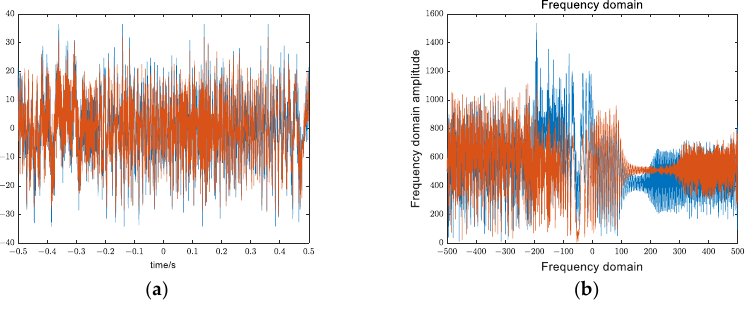
Figure 6. Mixed signal after mixed matrix. ( a ) Time domain; ( b ) Frequency domain.